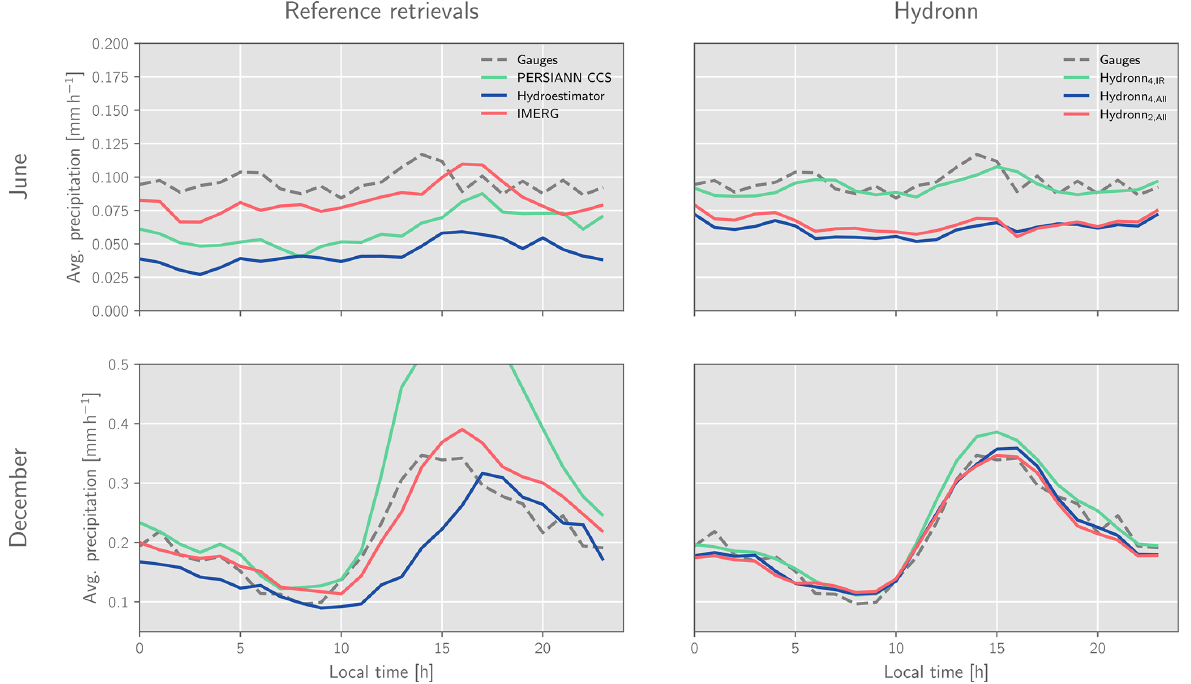
Figure 13. Measured and retrieved daily cycles of precipitation. The first column displays the daily cycles retrieved by the three reference retrievals (solid lines) and the gauge measurements (dashed line) for reference. The second column corresponds to diurnal cycles for the three Hydronn configurations. The first row shows the results for June 2020, and the second row shows results for December 2020.